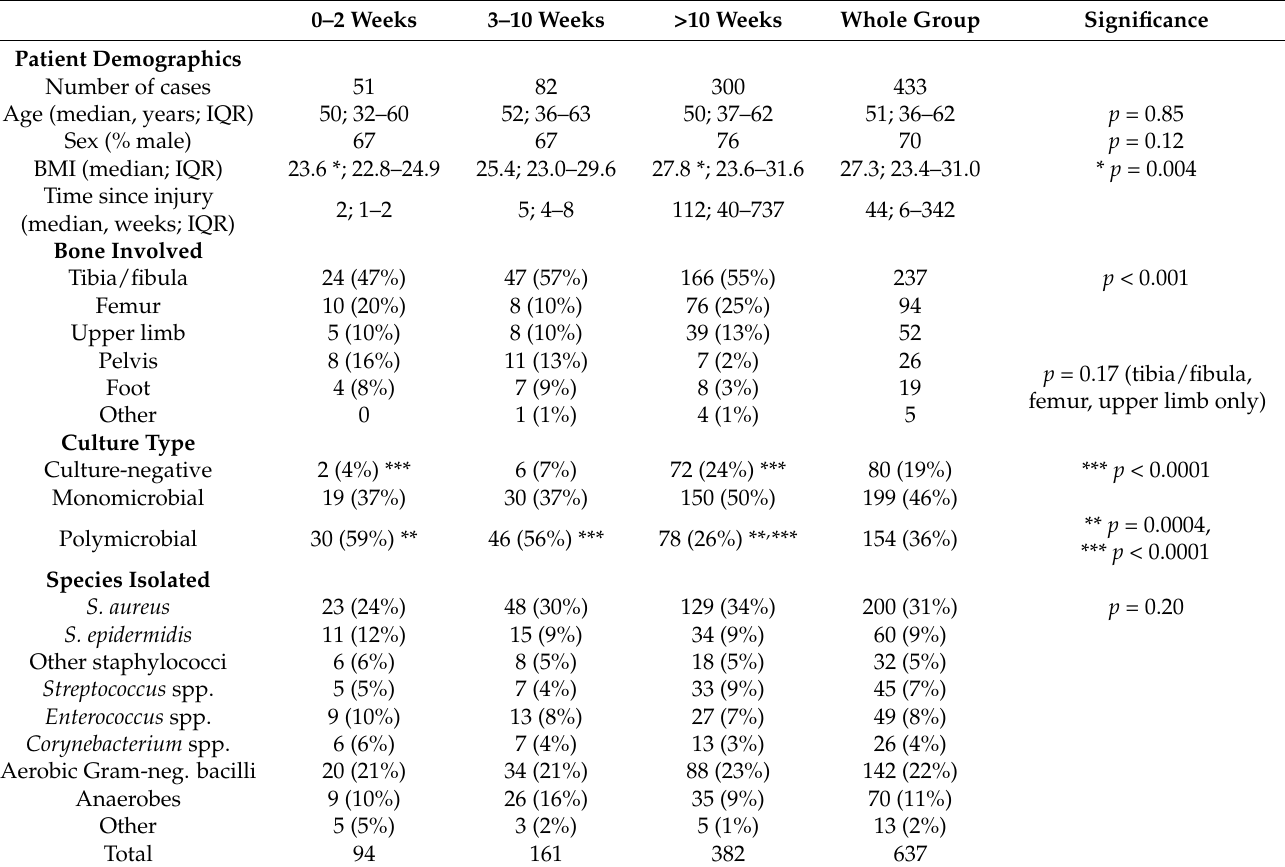
Table 1. Patient Demographics and Microbiological Results by Time Since Injury.